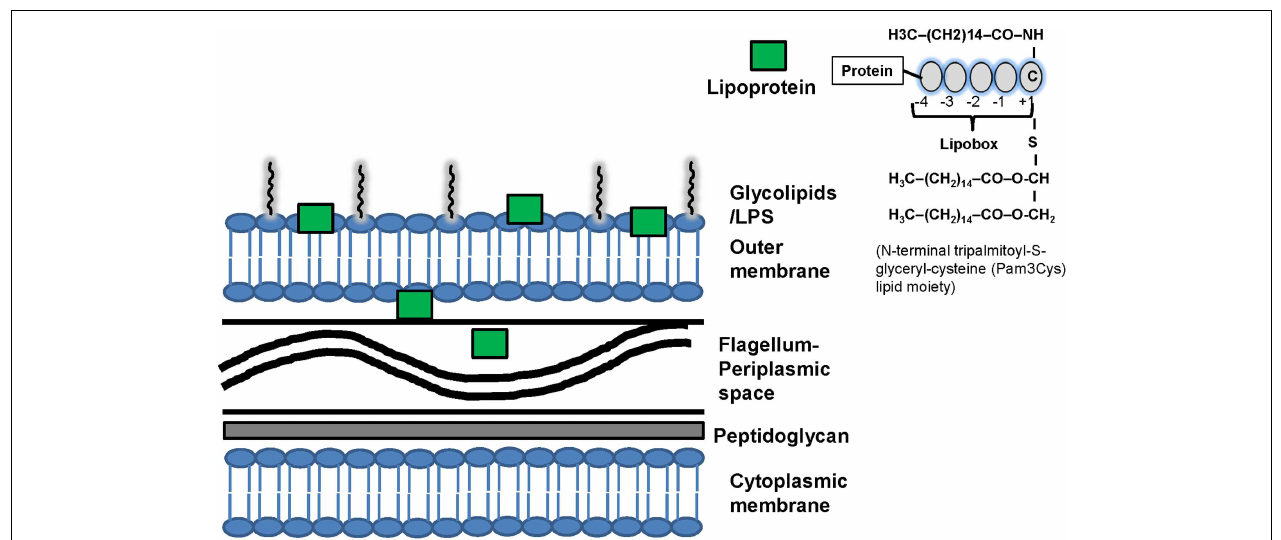
but do not determine the location of lipoproteins in the cells. Recently, developed fluorescence activated cell sorting (FACS) and surface proteolysis methods can be used to screen for lipoprotein localization. Right upper corner: structure of spirochetal lipoproteins.The finding of a cysteine